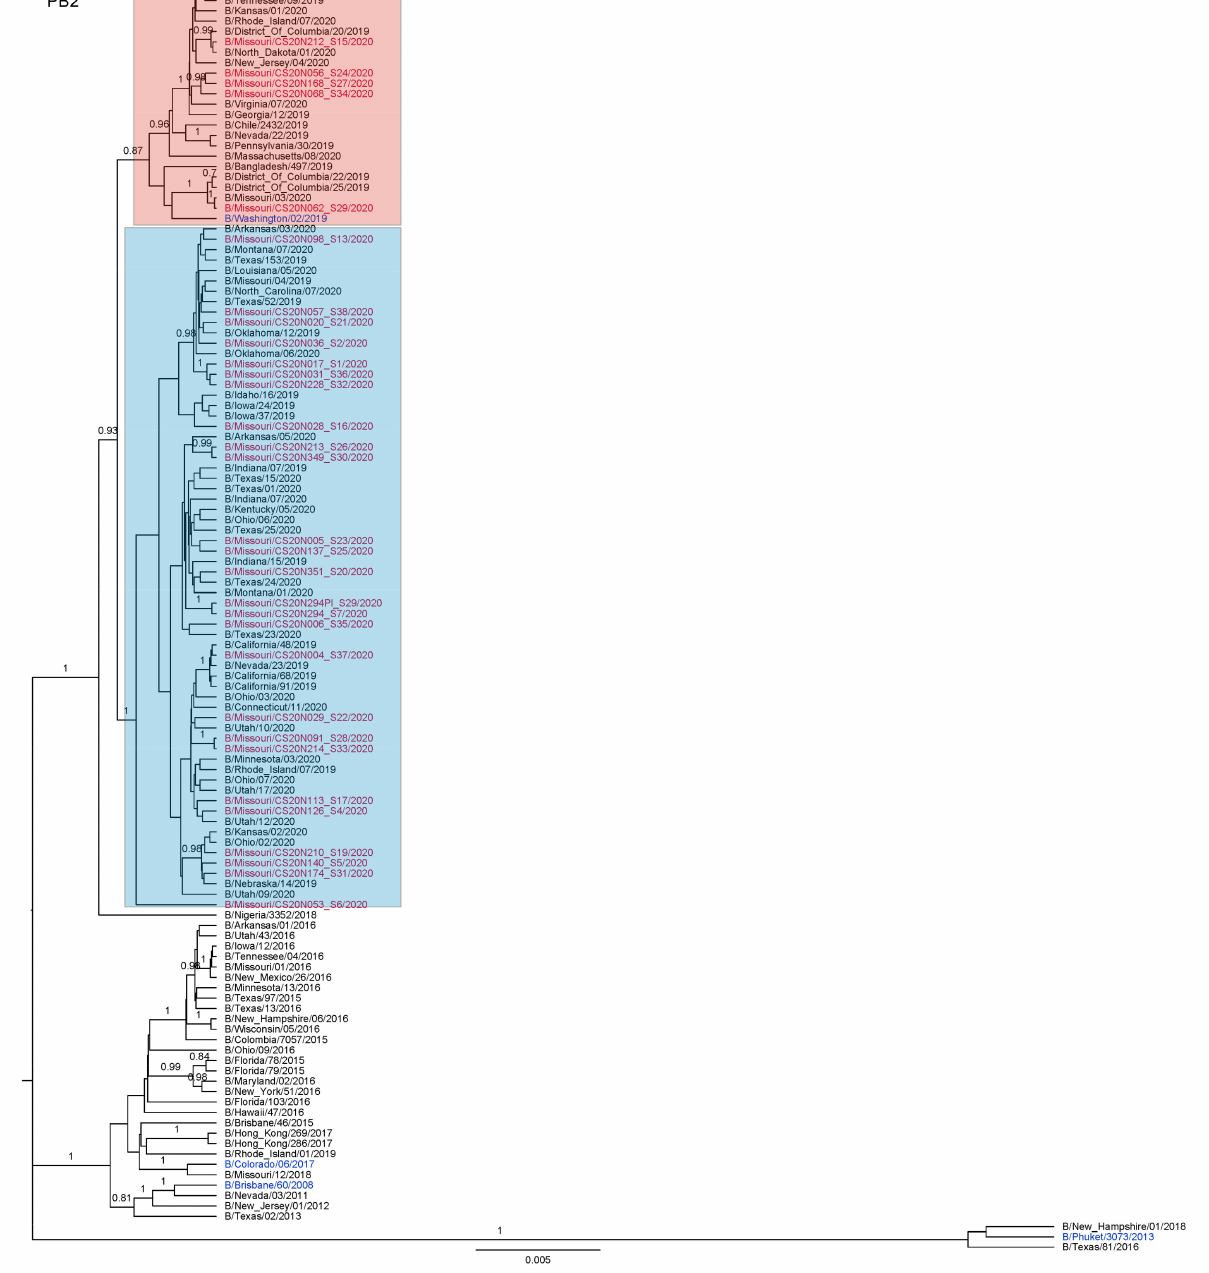
Figure A1. PB2 Tree. The phylogenetic analyses were performed by using BEAST2 with a Hasegawa–Kishino–Yano (HKY) substitution empirical model, strict clock model, and coalescent constant population prior. Branches with a posterior probability >0.70 were